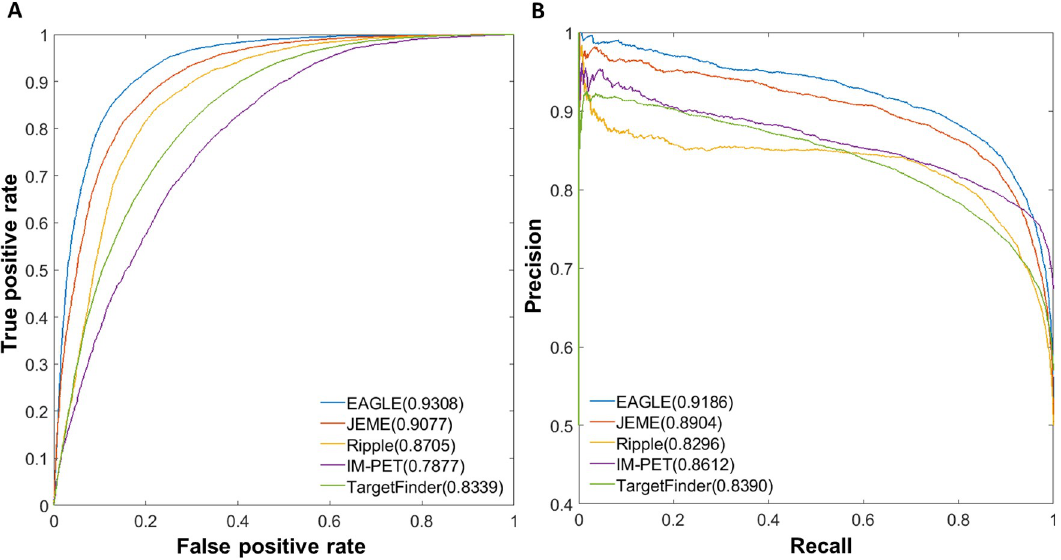
Fig 4. Performances of EG prediction tools based on cross-sample validation. (A) Relative AUROCs for all five methods (B) AUPRs for these methods. The model was trained based on K562 dataset while the prediction was made in GM12878 (see